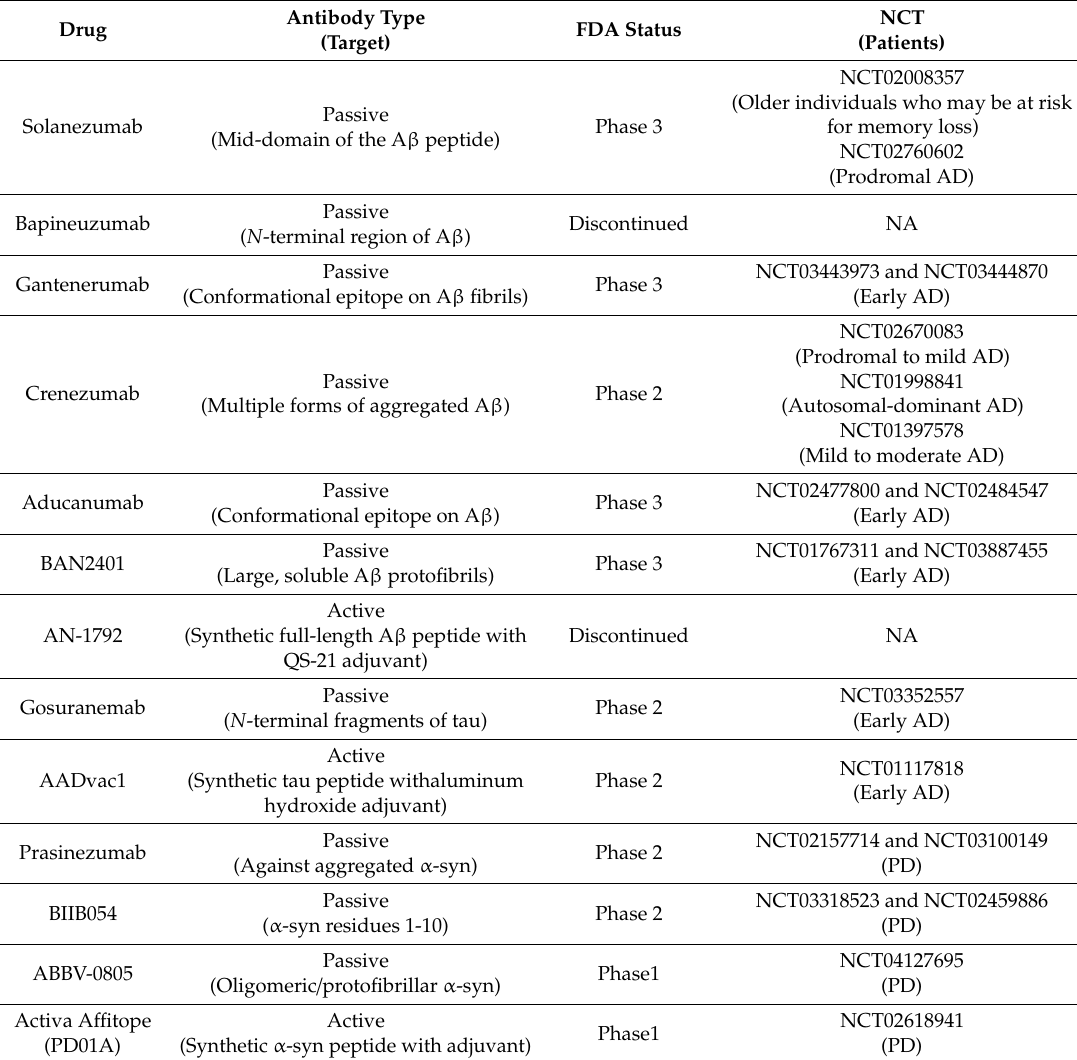
Table 2. Clinical trials of immunotherapies for neuronal degenerative